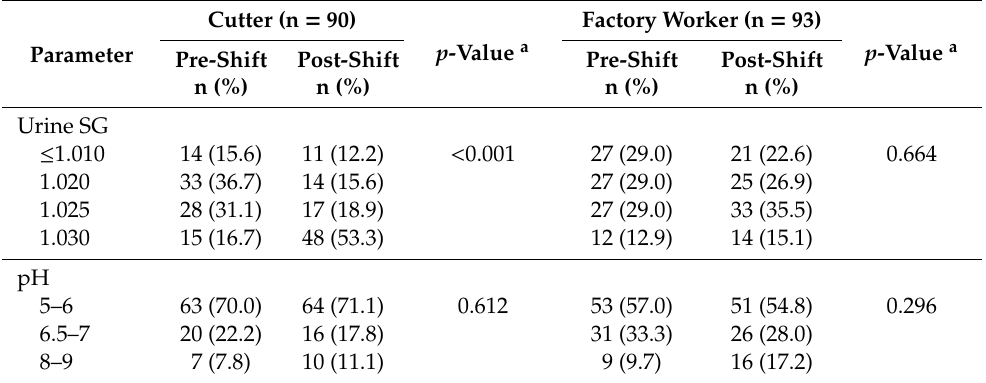
Table 5. Urine dipstick measures among sugarcane workers across the work shift. Cutter (n = 90) Factory Worker (n = Parameter